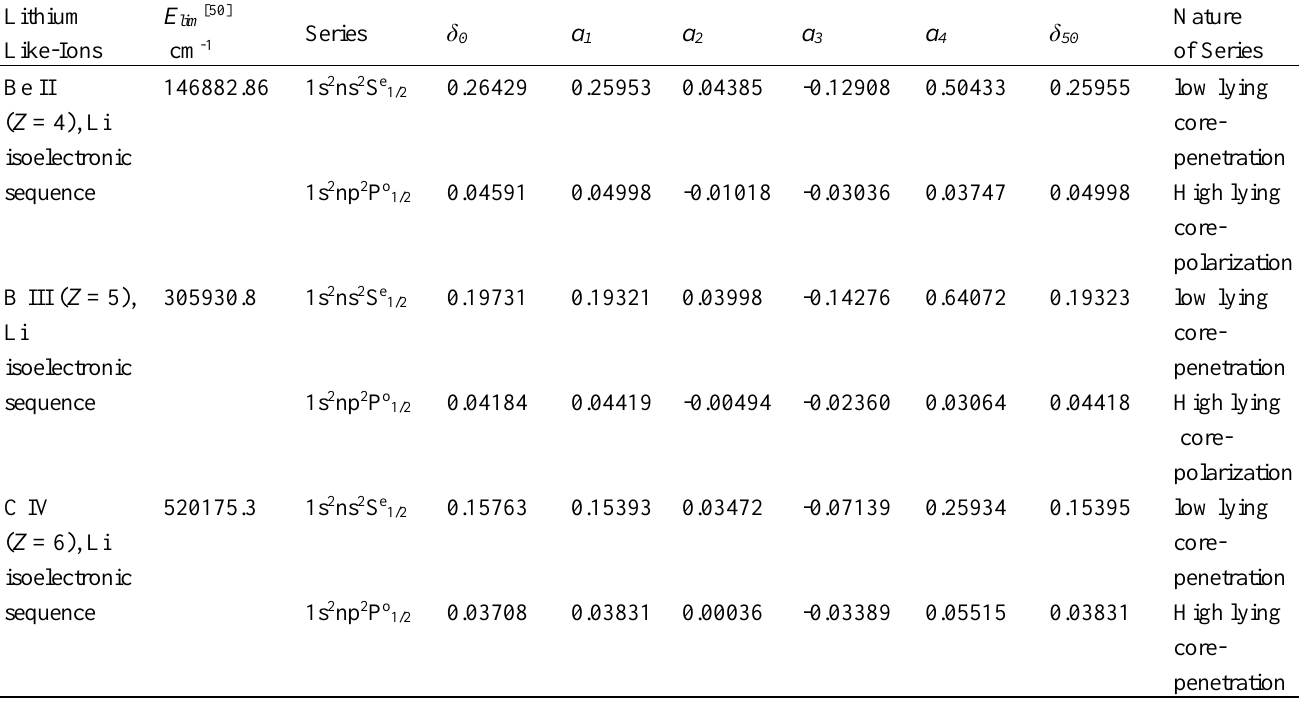
The coefficients of coupled Eqs. 24, 29 and 30 with nature of series